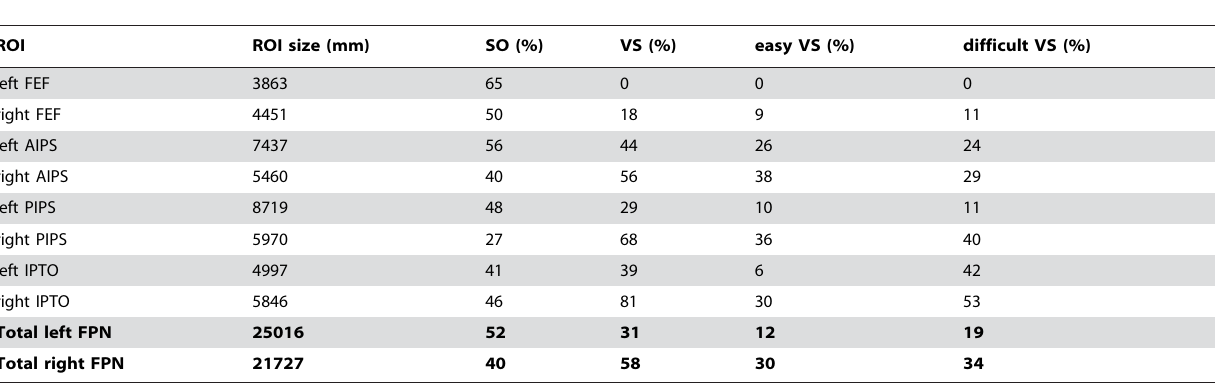
Table 2. Activated voxels in the left and right ROIs of the FPN during spatial orienting (SO) and visual search (VS).